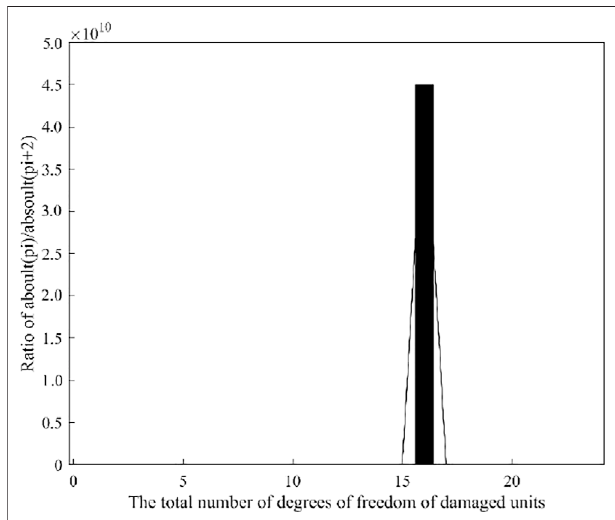
FIGURE 5 | Total number of freedom degrees of damage elements.